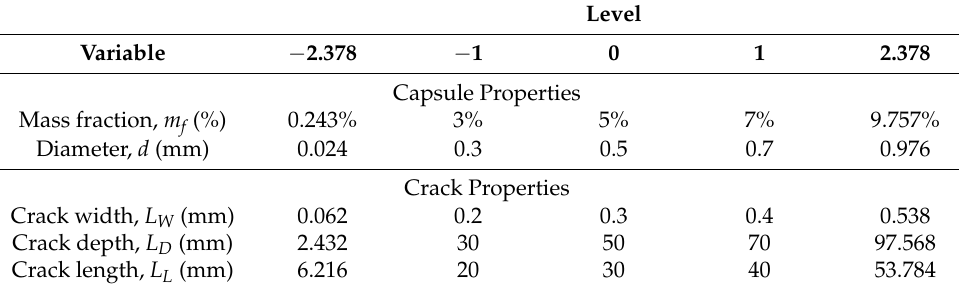
Table 1. Variables and levels considered for full five-factor CCC factorial design.